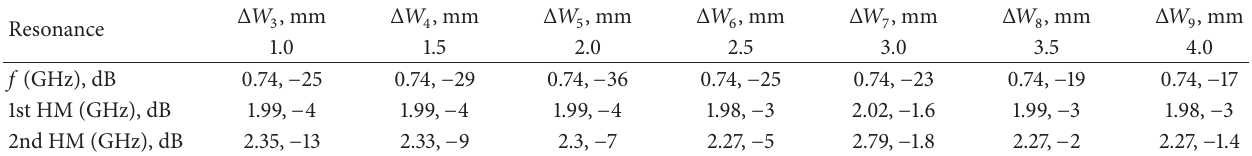
Figure 2: Measured return losses of the TMFDB25 antenna at two conditions: (1) TMFDB25 without stubs and (2) TMFDB25 with stubs 1, 2. In this study, 𝑓 equals 705 MHz while 1st HM = 1.972 GHz and 2nd HM = 3.048 GHz, and suppressed return losses of 1st HM and 2nd HM equals − 1.7429 dB and − 1.3321 dB, respectively. Table 6: Effect of stubfilter’s width on resonance in Figure 1.